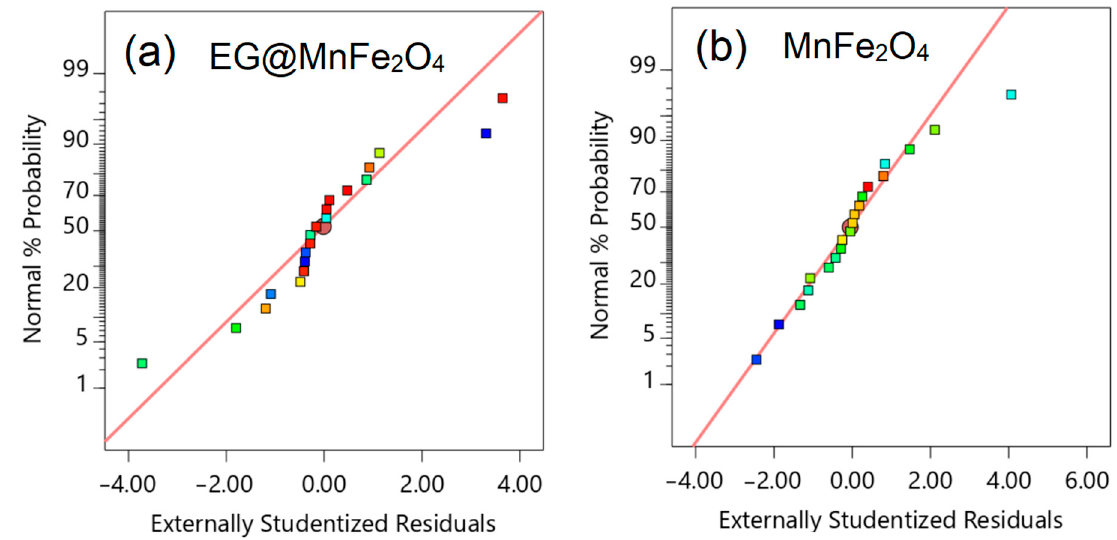
Figure 6. Externally Studentized residuals versus normal probability plots for the adsorption of CR onto EG@MnFe 2 O 4 ( a ) and MnFe 2 O 4 ( b ).